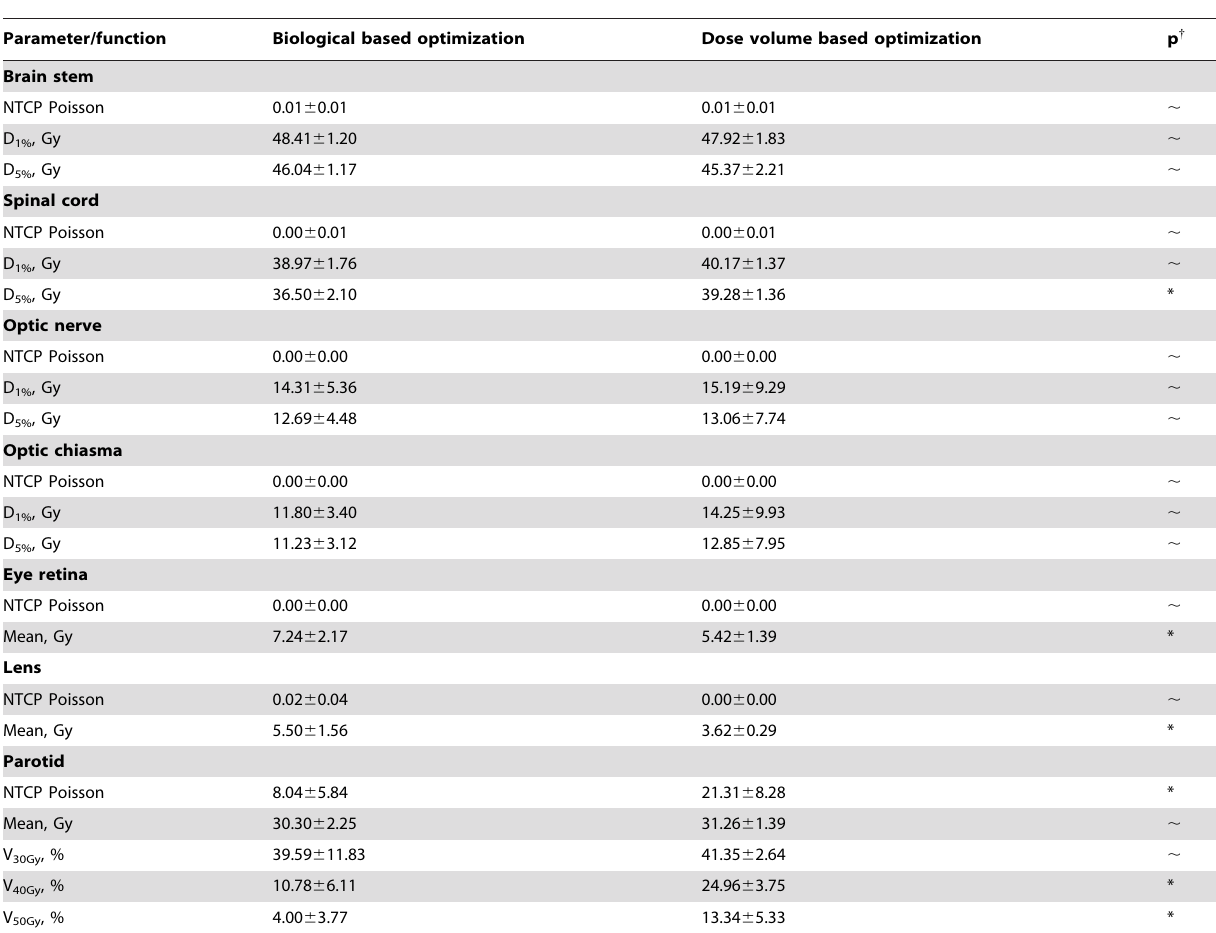
Table 6. Summary of biological and physical evaluation results for OARs averaged over 10 early stage NPC patients.